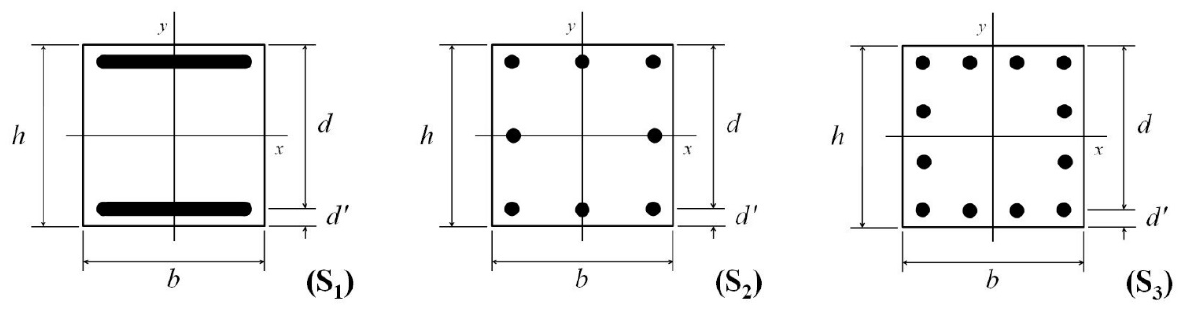
Figure 13. Cross-sections of the columns considered in the